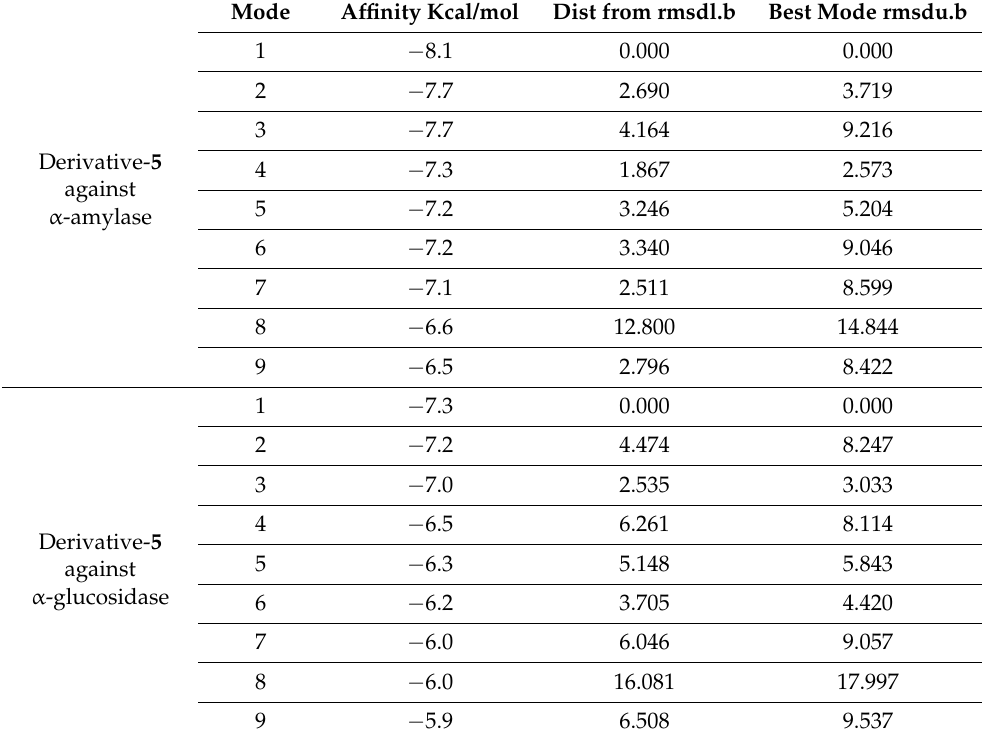
Table 3. The binding affinity and RMSD value of derivative- 5 against α -amylase and α -glucosidase.